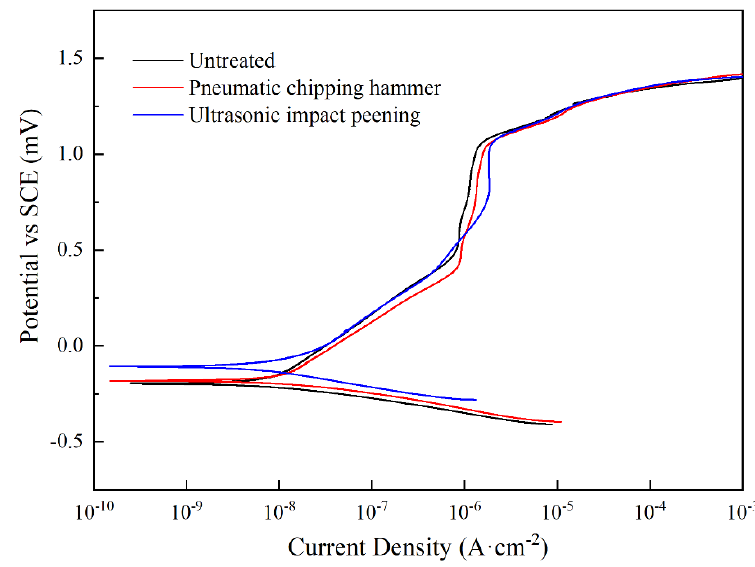
Figure 8. Polarization curve of the welded joints with different treatment methods. Table 2. Experimental results of the electrochemistry of welded joint with different treatments. Treatment